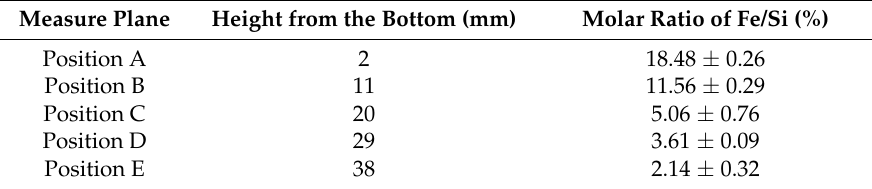
Table 1. Molar ratio of Fe/Si at different heights of the composition-gradient aerogel. Measure Plane Height from the Bottom